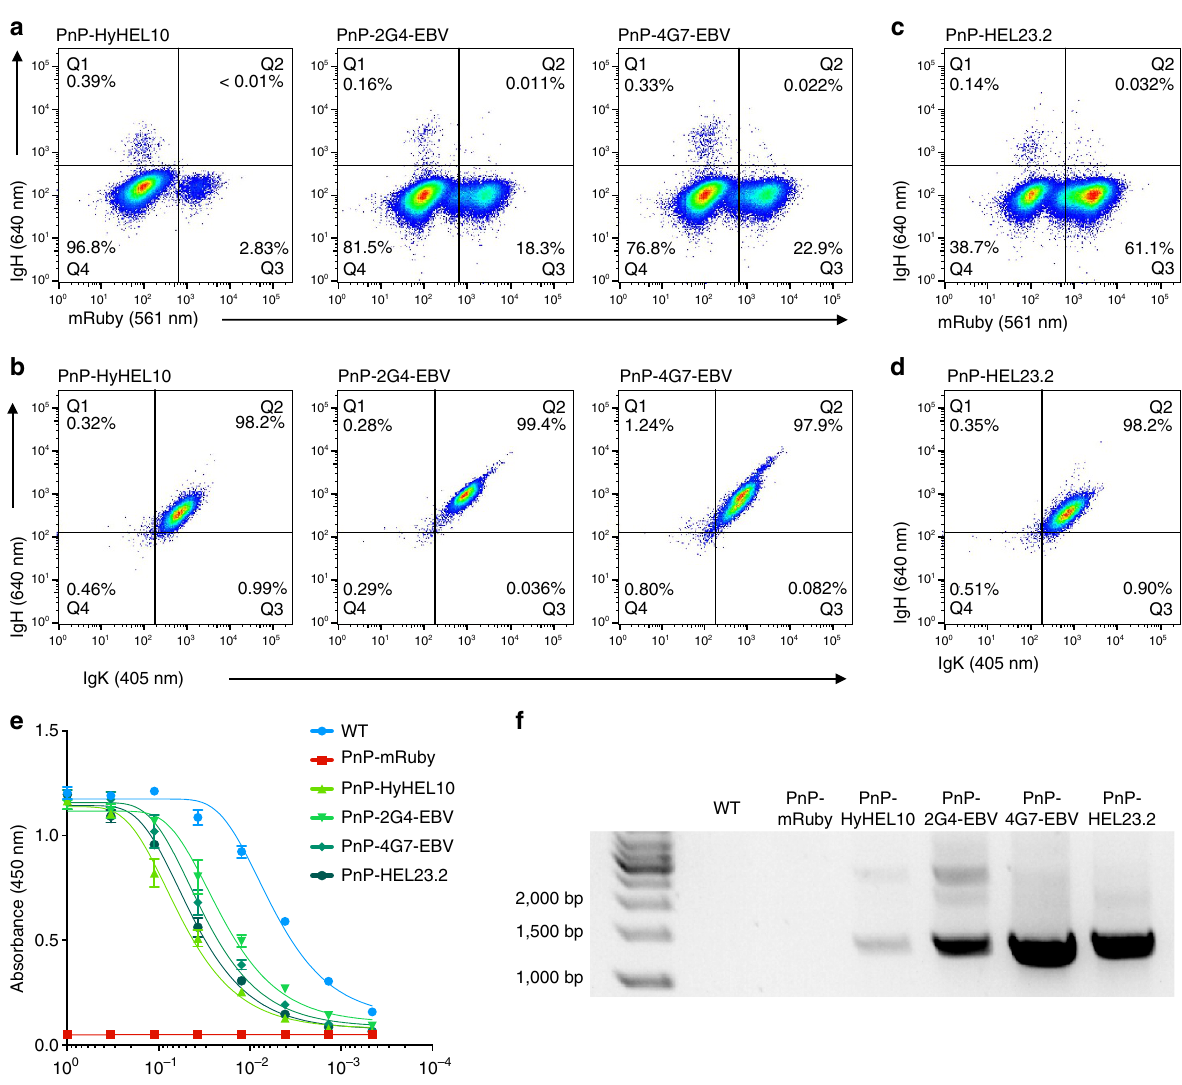
Figure 4 | Rapid and reproducible antibody reprogramming in PnP-mRuby cells. ( a ) Flow cytometry dot plots show PnP-mRuby cells following transfection with CRISPR-Cas9 plasmid and different PnP-sAb donor constructs encoding antibodies specific for HEL or Ebola virus glycoprotein (EBV). The cells were sorted for IgH expression. ( b ) Flow cytometry dot plots show that all three PnP cell lines express IgH and IgK following sorting in a . ( c , d ) Similar to a and b are flow cytometry dot plots for PnP-HEL23.2 cells, which were generated in the same manner as PnP-HEL23 with the exception that the Cas9 þ (2A-BFP) sorting step was omitted. ( e ) As in Fig. 2f, plot generated from sandwich ELISA demonstrating that all versions of PnP-antibody producing cells secrete IgG into the supernatant. For each sample, three technical replicates were analysed and a four-parameter logistical curve was fitted to the data by nonlinear regression. Data are presented as the mean and error bars indicate standard deviation. ( f ) As in Fig. 2h, RT–PCR performed on mRNA verified correct insertion and splicing of sAb donors (WTand PnP-mRuby cells received a mixture of forward V L -specific primers). Throughout this figure, PnP-HyHEL10 corresponds to clone U, PnP-2G4-EBV corresponds to clone AA, and PnP-4G7-EBV corresponds to clone AB, PnP-HEL23.2 corresponds to clone AC (for more details, see Supplementary Table